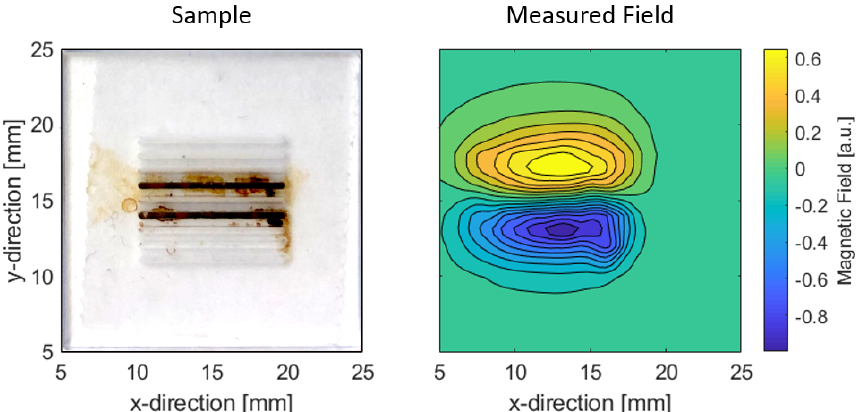
Figure 6. ( Left ): image of the sample with MNP in trenches. ( Right ): measured magnetic field of the